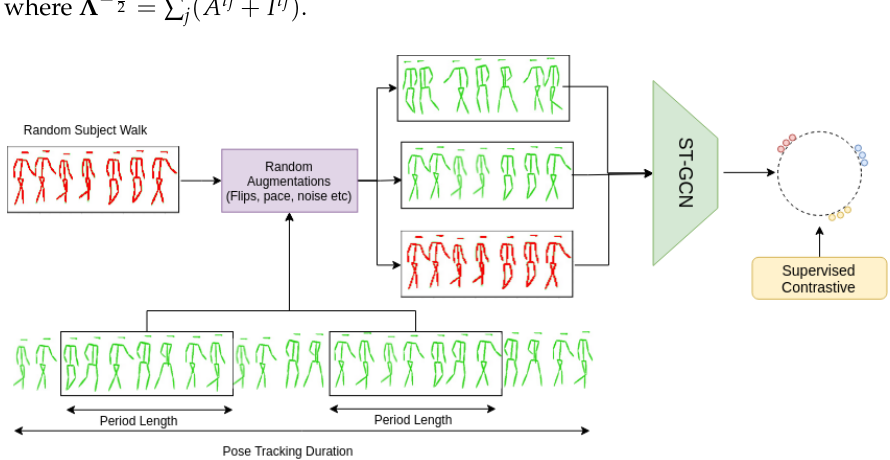
Figure 5. WildGait training methodology. Given a tracked sequence of skeletons, we employ Supervised Contrastive (SupCons) loss on multiple augmented views (randomly cropped, flipped etc.) of the same person and a walk from a random subject in the dataset as a negative